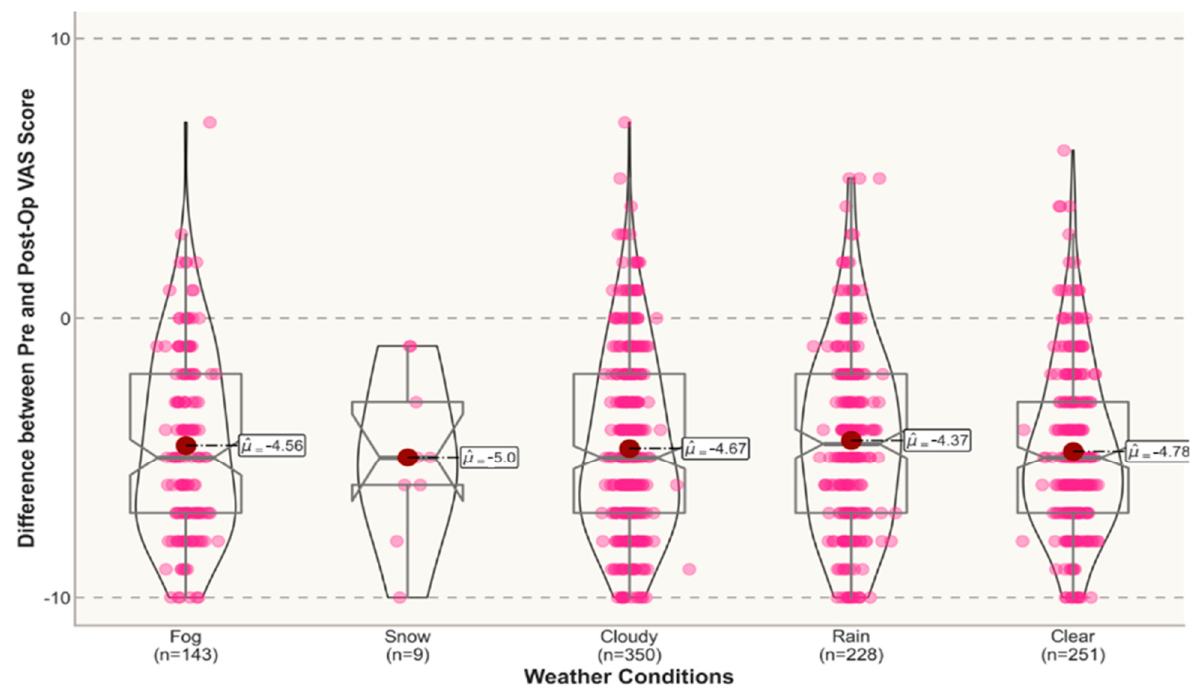
Figure 3. Differences between pre- and post-op scores in different weather conditions (3 months).